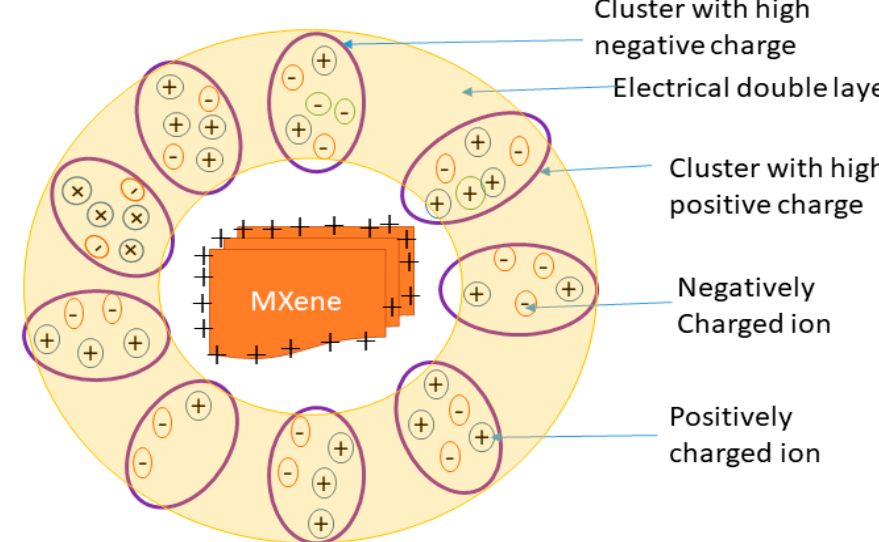
Figure 12. Types and characteristics of intermolecular forces.